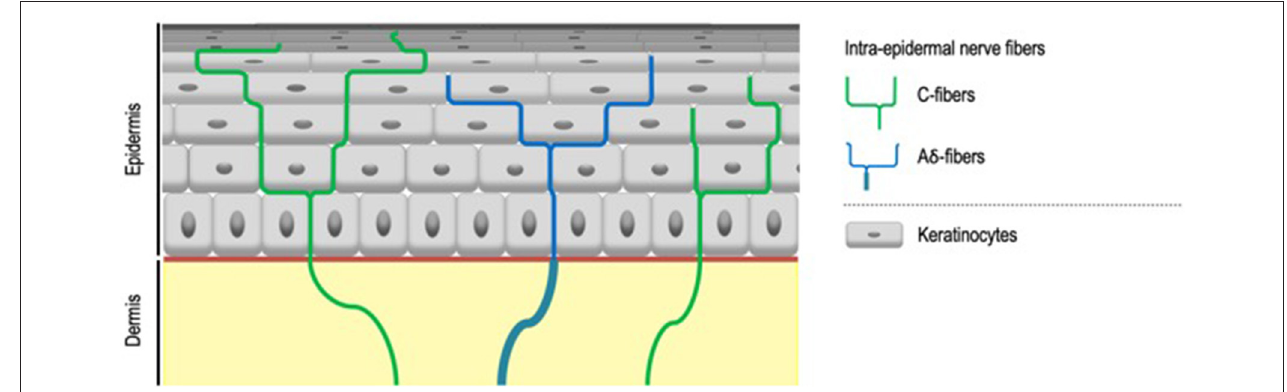
FIGURE 2 | Intra-epidermal nerve fibers. Intra-epidermal nerve fibers, classified as C- and A δ -fibers, unmyelinated, and thickly myelinated respectively, are conventionally described as the exclusive sensors for temperature, pain, and itch. A δ -fibers lose their myelin sheath when crossing the basement membrane.